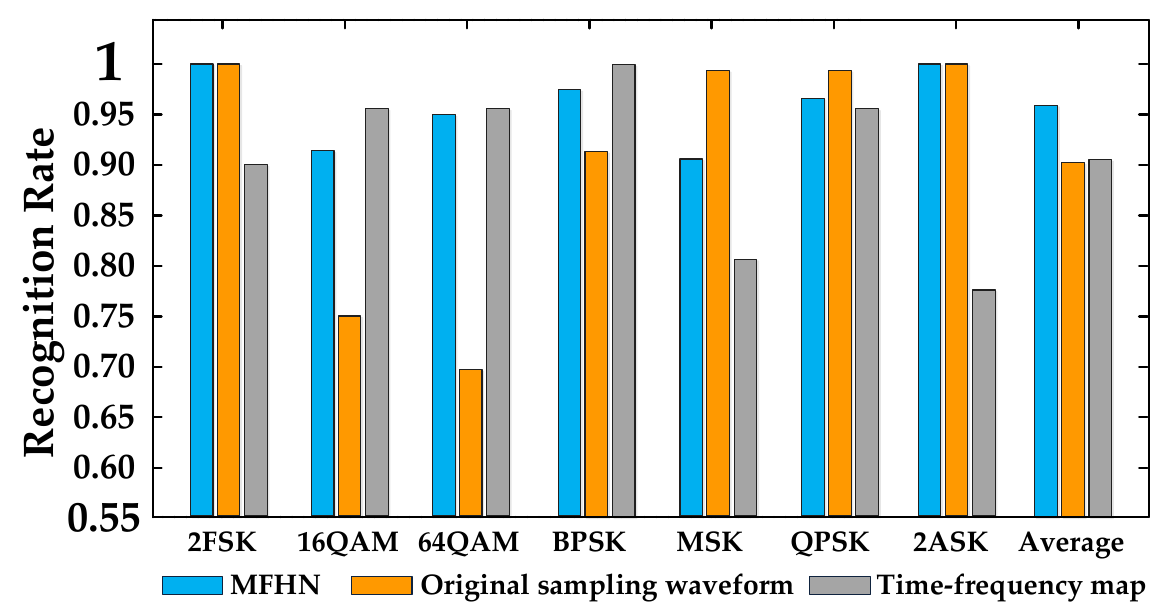
Figure 11. Modulation recognition based on signal dataset 1.